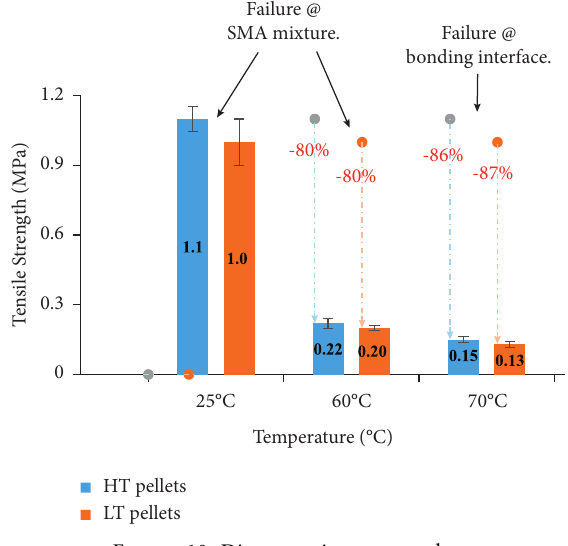
Figure 10: Direct tension test